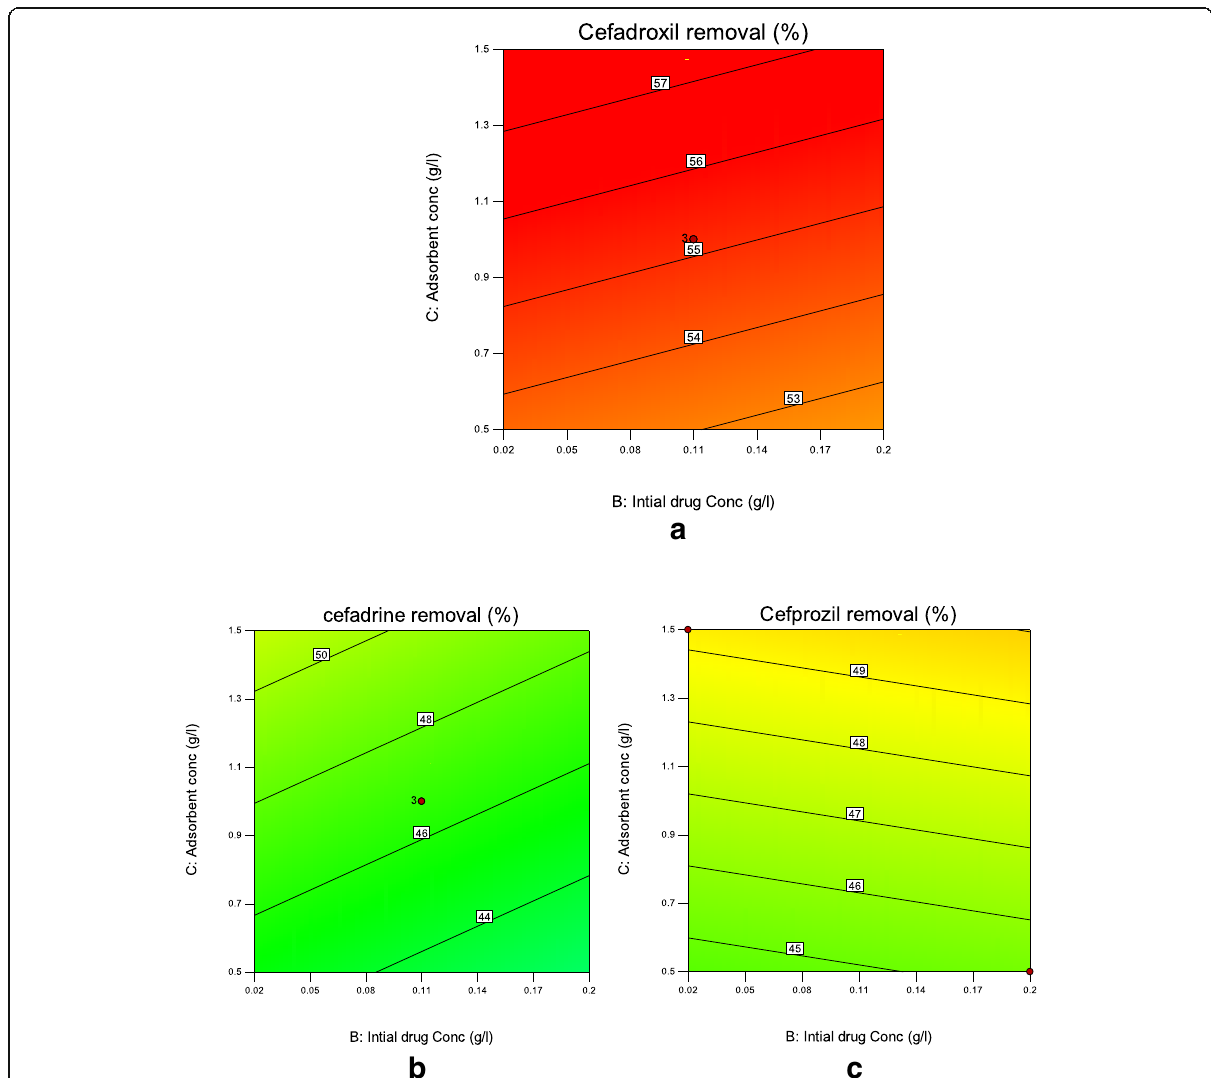
Fig. 5 Interaction of MSN loading dose with an initial concentration of a cefadroxil, b cefprozil, and c cefradine at constant pH